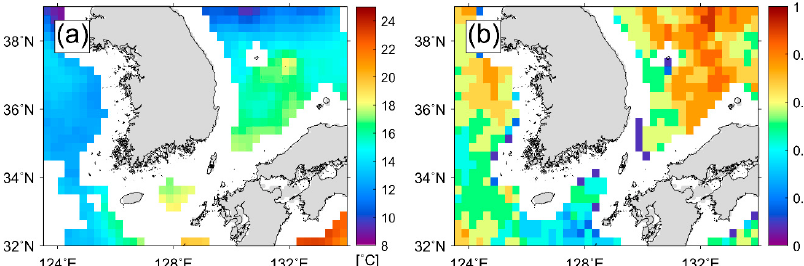
Figure 12. Spatial distribution of ( a ) sea surface temperature (SST) from the Advanced Microwave Scanning Radiometer 2 (AMSR2) on 25 April 2016 and ( b ) probability for AMSR2 observation for 2016.